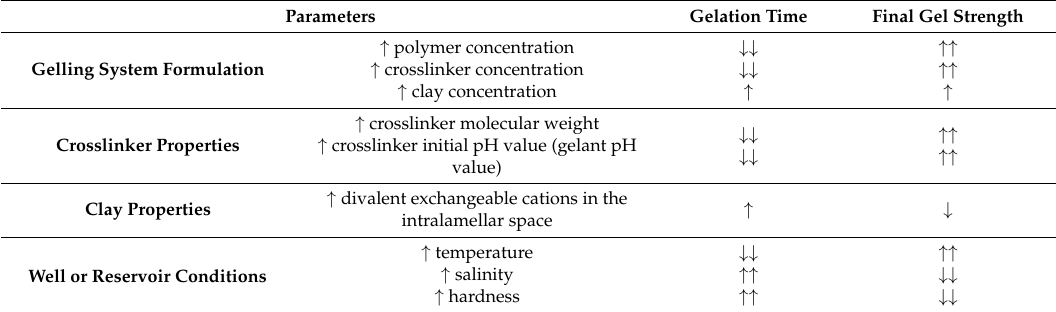
Table 3. Overview of the influence of the different parameters on the gelation time and gel strength.